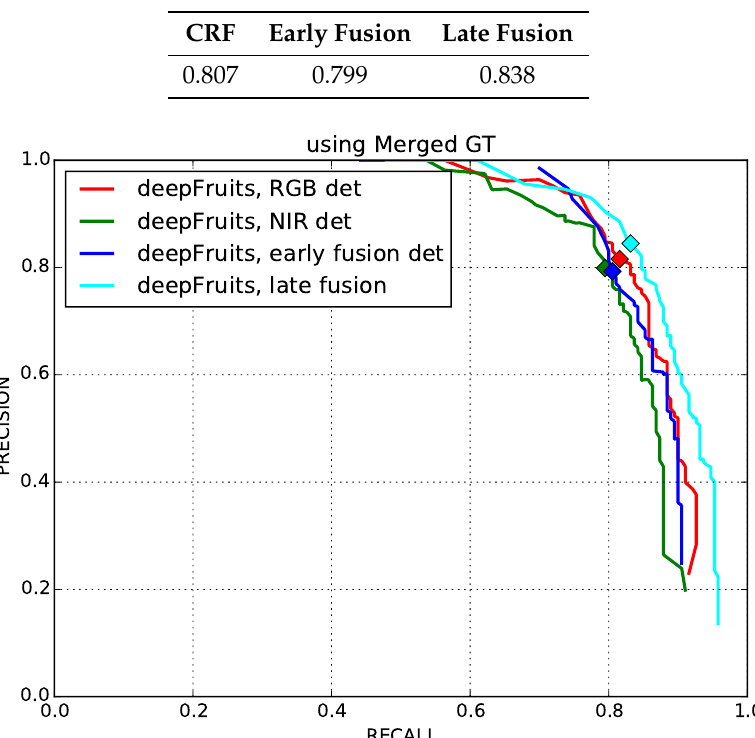
Table 3. F1 scores of CRF and fused networks.